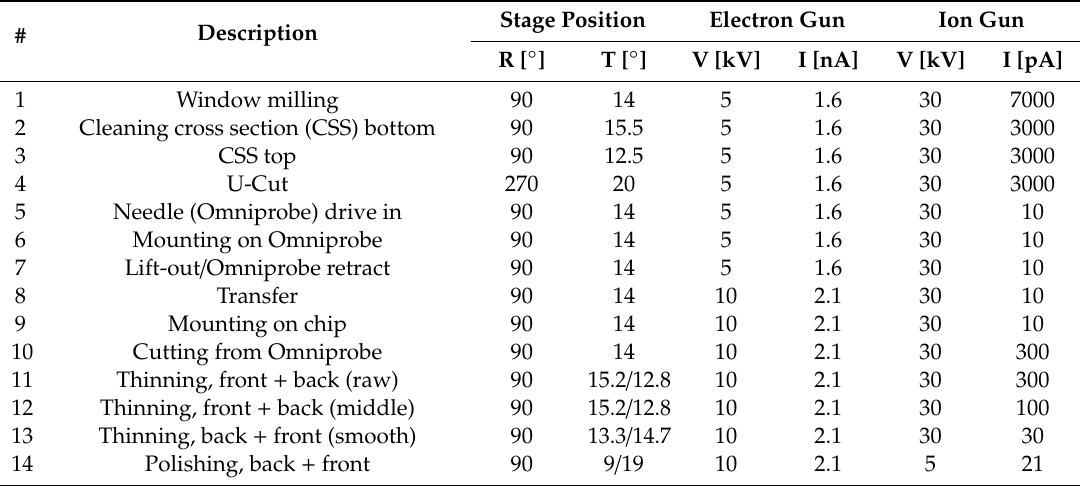
Table A1. Step by step protocol for the in-situ lift-out and transfer procedure of a cross-sectional thin film